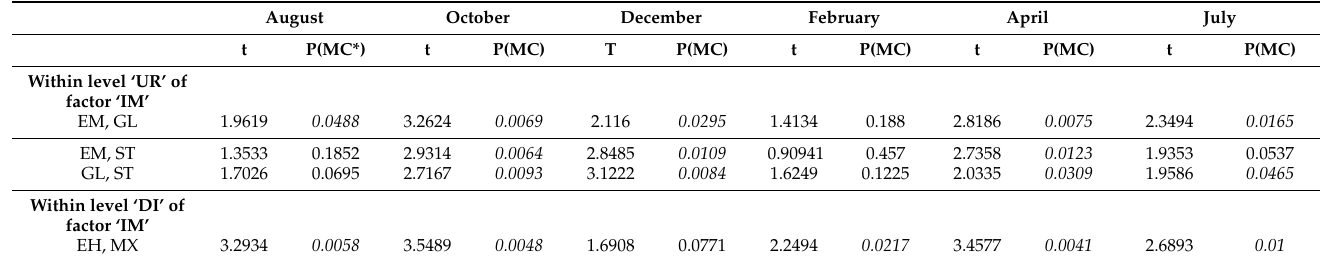
Table 6. The PERMANOVA pairwise test for pairs of levels of factor “site” within levels of the factor “impact” per each level of the factor “time”. Due to the low number of unique permutations, significance was calculated using Montecarlo (MC)